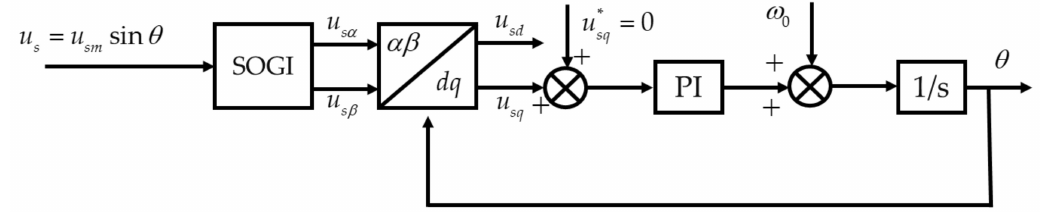
Figure 4. The control structure of the